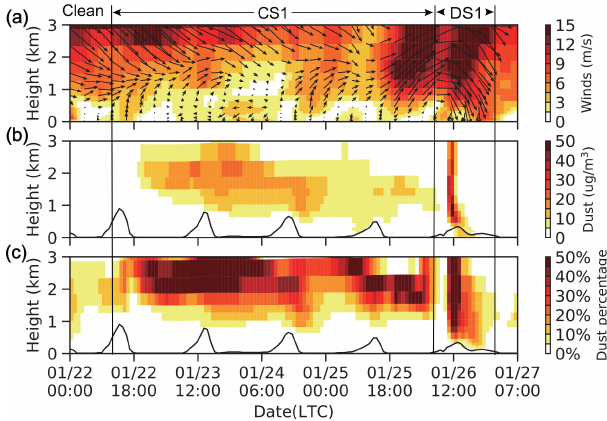
Figure 5. Curtain plots of winds and dust concentrations in CWBF from 22 to 26 January 2017. (a) Winds simulated by WRF-Chem, (b) vertical structure of dust concentrations, and (c) vertical struc- ture of the composition of dust in total PM 10 concentrations. The black arrow in (a) indicates the wind direction; the upper arrow is for south winds. The black lines in (b) and (c) represent the PBL height evolution in WRF-Chem.